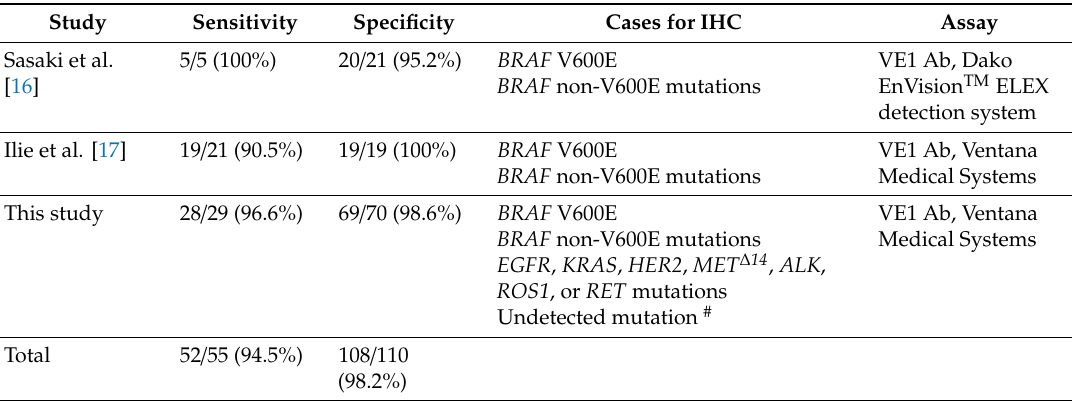
Table 4. Sensitivity and specificity of immunohistochemical detection for patients with lung adenocarcinoma harboring BRAF V600E in di ff erent